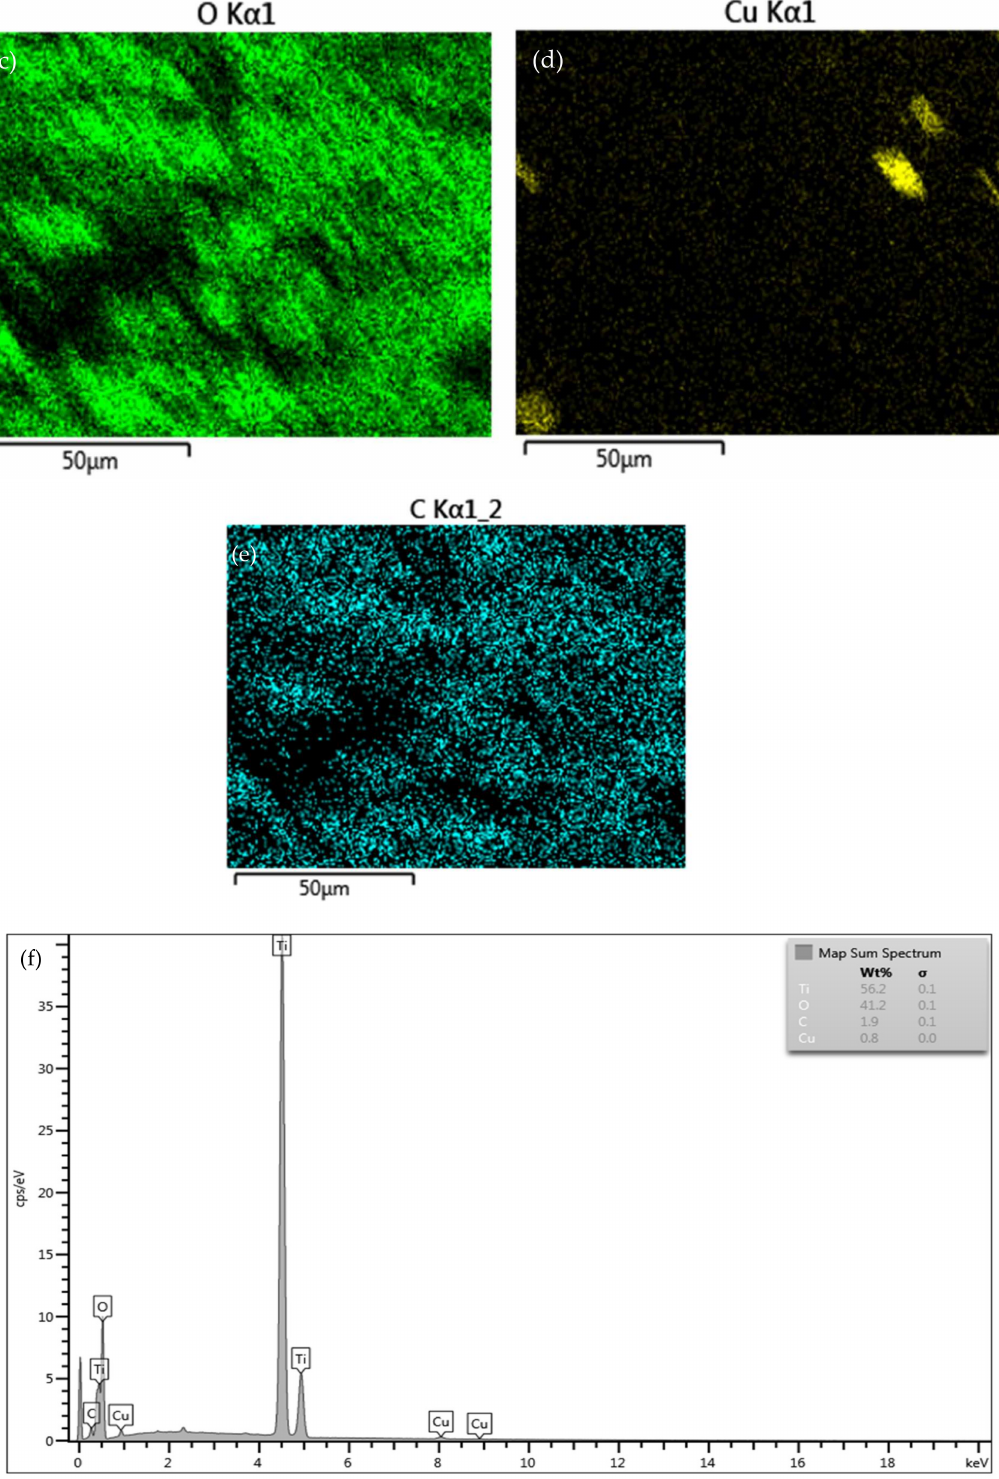
Figure 4. EDX elemental mappings of TiO 2 /annealed C1020 fracture coating: ( a ) SEM; ( b ) titanium; ( c ) oxygen; ( d ) copper; ( e ) carbon; ( f ) map sum